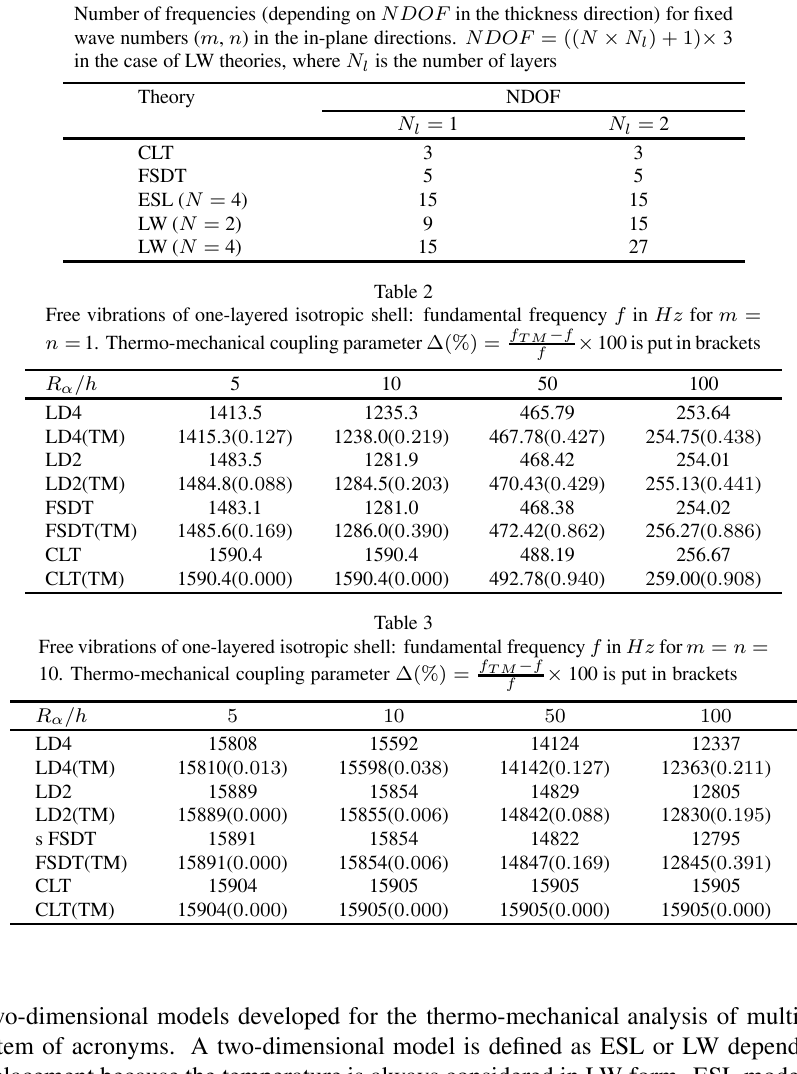
Table 1 Number of frequencies (depending on NDOF in the thickness direction) for fi xed